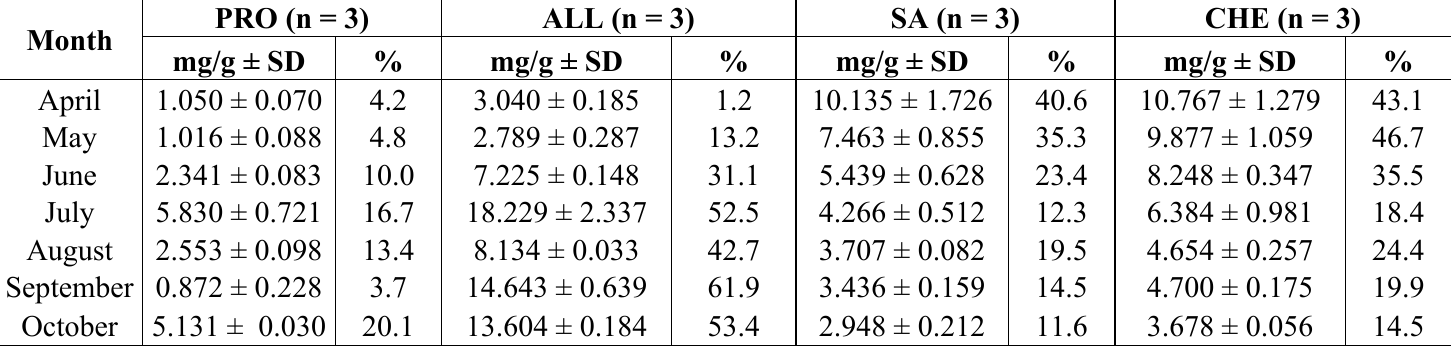
Table 2. The amount of isoquinoline alkaloids during the vegetation period–aerial parts of M.